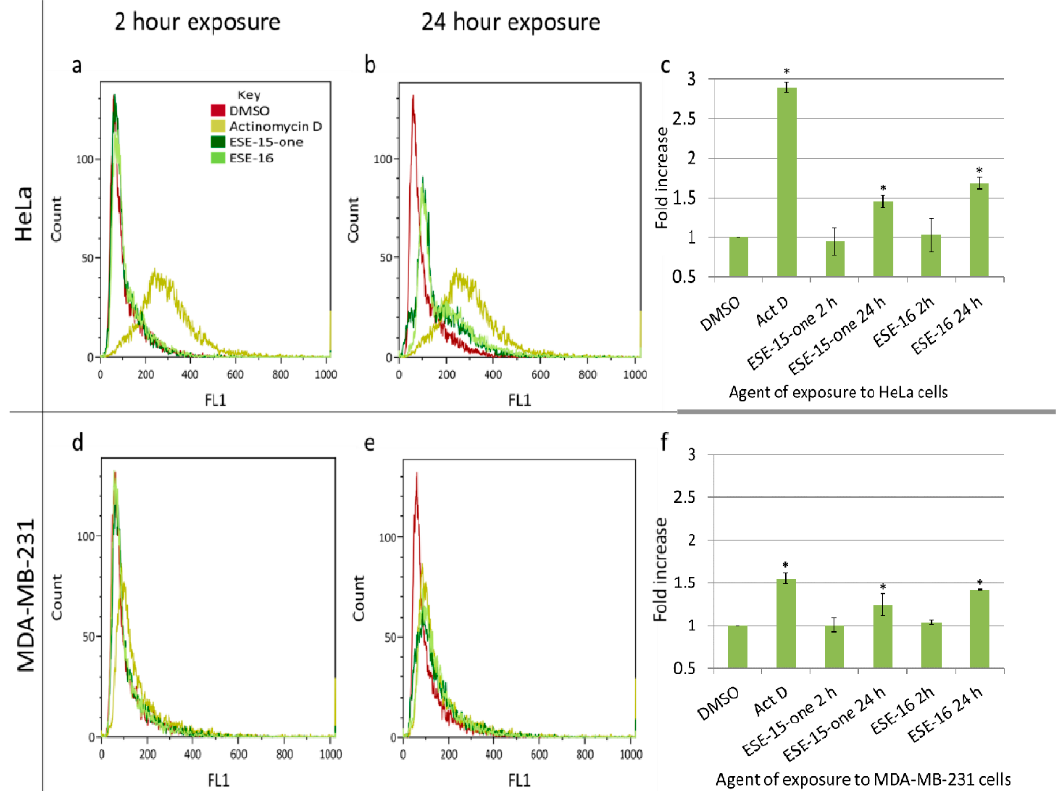
Figure 5. Quantification of the loss in the mitochondrial transmembrane potential induced by ESE-15-one and ESE-16 exposure. Overlay histograms of HeLa ( a ) and MDA-MB-231 ( d ) cells after a 2 h exposure to the compounds. Overlay histograms of HeLa ( b ) and MDA-MB-231 ( e ) cells after a 24 h exposure to the compounds, showing a right shift in the curve indicating the loss of mitochondrial transmembrane potential. The fold-increase in mitochondrial membrane depolarization is summarized in bar charts for HeLa-( c ) and for MDA-MB-231 cells ( f ). Standard deviation represented by error bars, * p < 0.05. The key provided in (a) applies to all the overlay histograms presented.